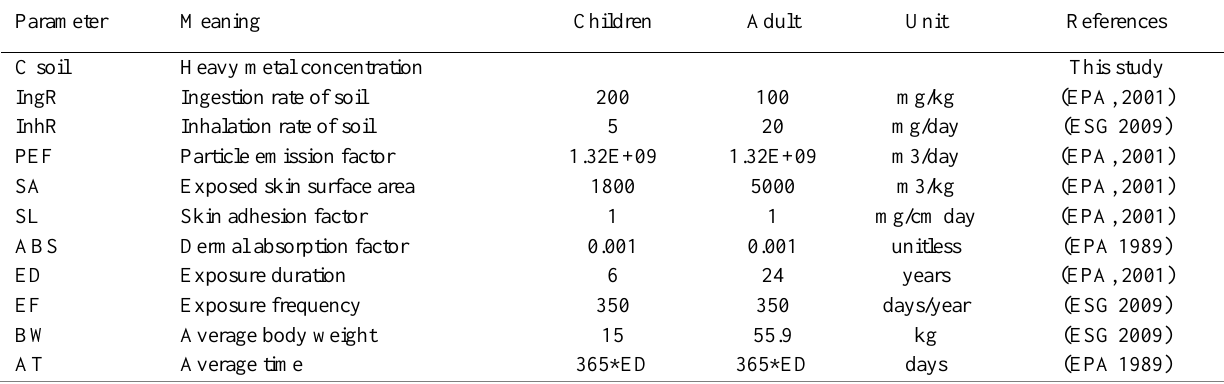
Table 1 . Parameter values in ADD calculation models of heavy